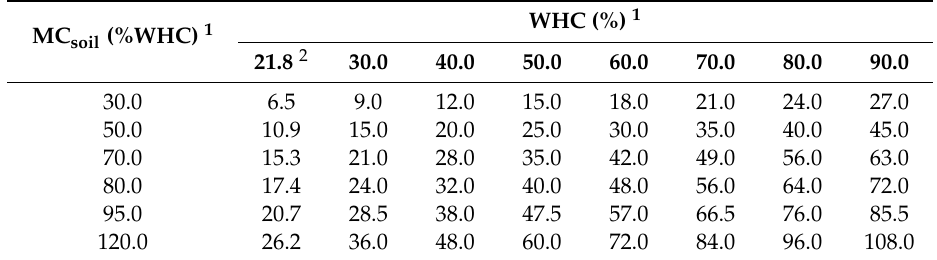
Table 2. Soil moisture content MC soil (%) for combinations of target WHC 1 and target MC soil expressed as